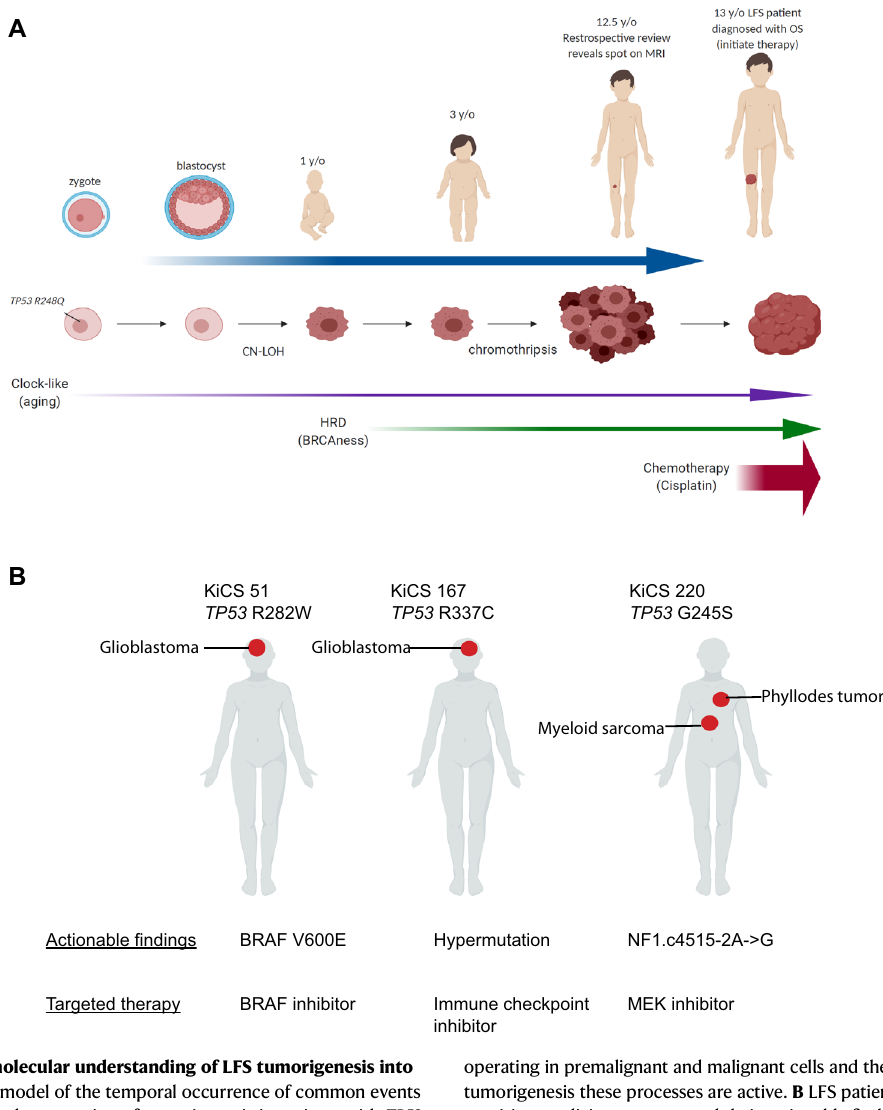
operating in premalignant and malignant cells and the approximate times in tumorigenesis these processes are active. B LFS patients enrolled in the KiCS precision medicine program and their actionable fi ndings with corresponding potential targeted